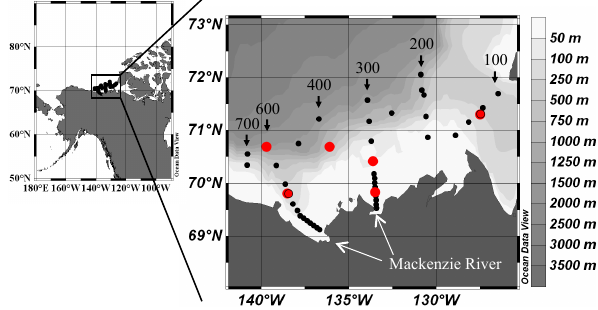
Fig. 1. Study area. Transect numbers from the sampling grid are marked by top labels. Stations where respiration experiments were performed are marked in